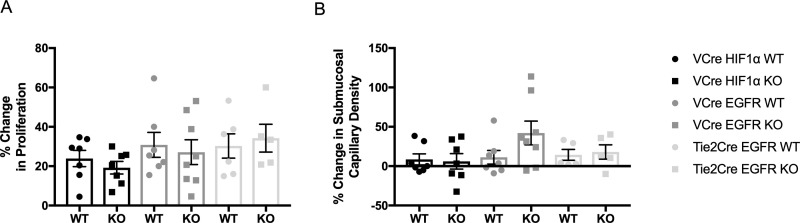
Changes in crypt proliferation and submucosal capillary density.(A) Percentage change in crypt proliferation from IO to POD7 in VillinCreER(+/-)HIF1α(flox/flox) WT (n = 7) and KO (n = 7) mice, VillinCreER(+/-)EGFR(flox/flox) WT (n = 7) and KO (n = 8) mice, and Tie2CreER(+/-)EGFR(flox/flox) WT (n = 6) and KO (n = 5) mice. (B) Percentage change in submucosal capillary density from IO to POD7 in VillinCreER(+/-)HIF1α(flox/flox) WT (n = 7) and KO (n = 7) mice, VillinCreER(+/-)EGFR(flox/flox) WT (n = 7) and KO (n = 8) mice, and Tie2CreER(+/-)EGFR(flox/flox) WT (n = 5) and KO (n = 5) mice.